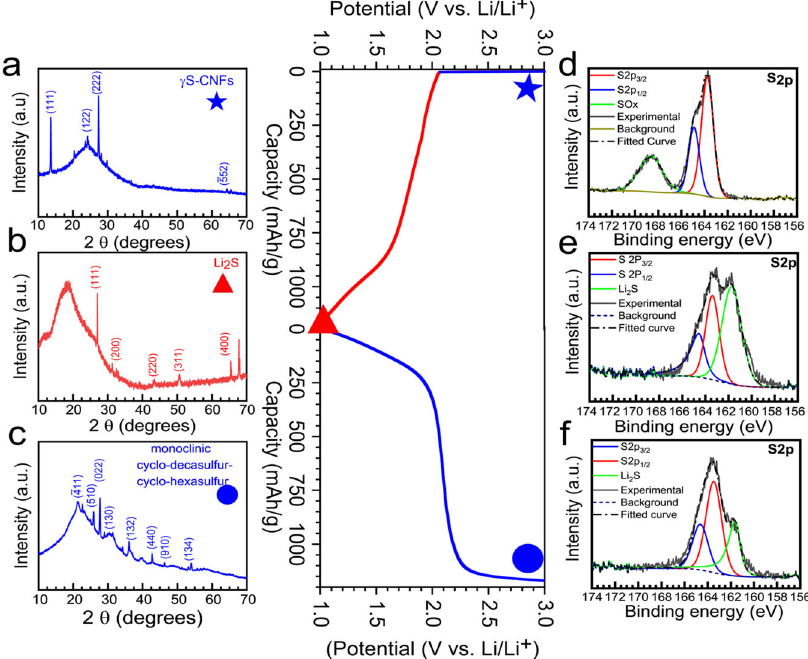
Fig. 7 Post-mortem XRD and XPS analysis of γ -S/CNFs after charge – discharge cycles. a – c XRD pattern of a. pristine γ S-CNFs. b Discharged γ S-CNFs showing conversion to Li 2 S. c Charged XRD pattern showing conversion to monoclinic cyclo-hexa-cyclo-deca sulfur. d – f High-resolution S2p XPS spectra of ( d ). Pristine γ S-CNFs. e Discharged γ S-CNFs displaying Li 2 S peak. f Charged γ S-CNFs showing the presence of sulfur peak. g – f High-resolution F1s spectra of g discharged γ S-CNFs, f charged γ